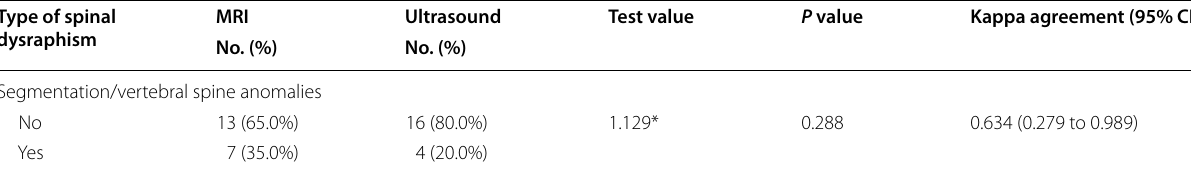
P value > 0.05: non-significant; P value < 0.05: significant; P value < 0.01: highly significant